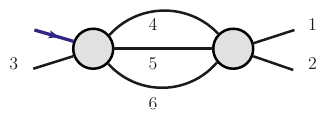
Figure 10 . The s 12 triple-cut.